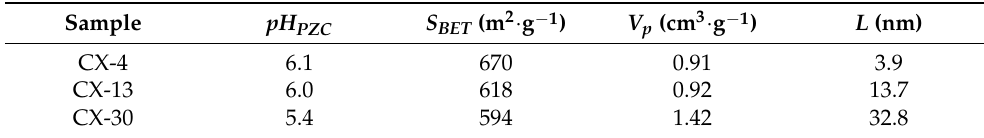
Table 1. Characterization of CX samples: point of zero charge ( pH PZC ), surface area ( S BET ), total pore volume ( Vp ), and average mesopore width ( L ), obtained by adsorption of N 2 at − 196 °C.